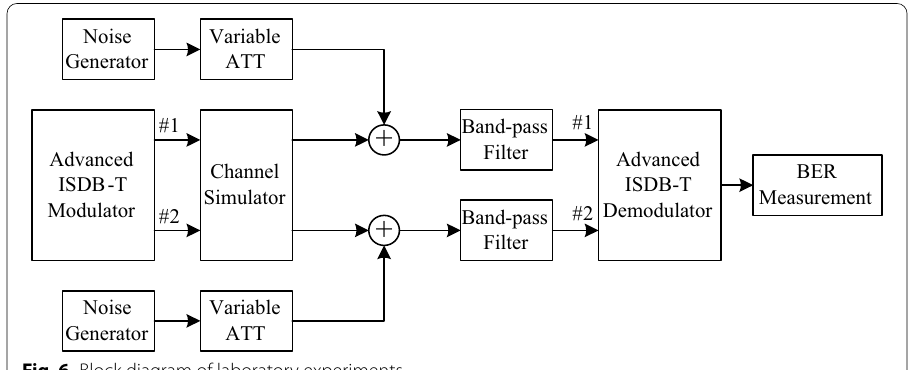
Fig. 6 Block diagram of laboratory